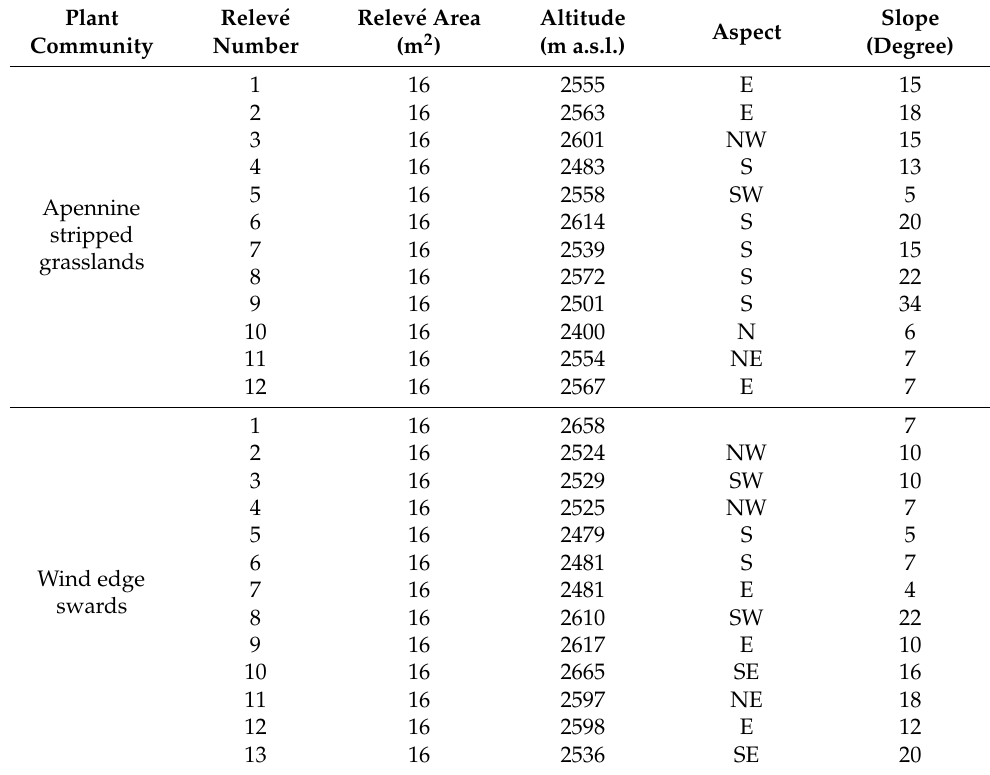
Table A1. Headers information of each re-sampled plot in both the studied plant